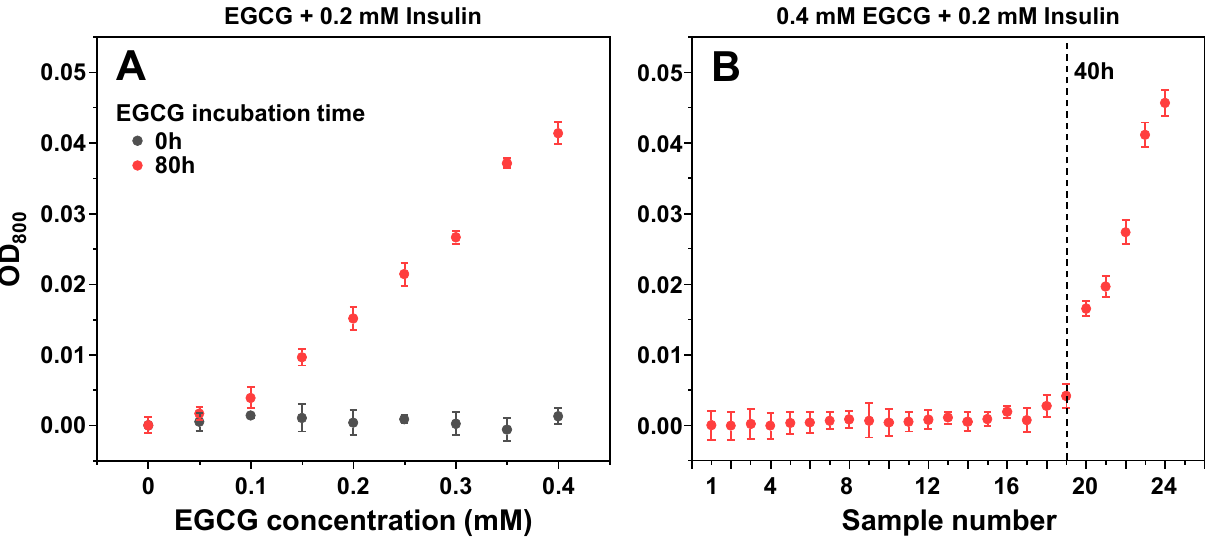
Figure 5. Optical density of insulin samples in the presence of different concentration ( A ) and incubation time ( B ) EGCG samples. Optical density measurement procedures are described in the Section 2. Optical density values are the average of three repeats (error bars are for one standard deviation).